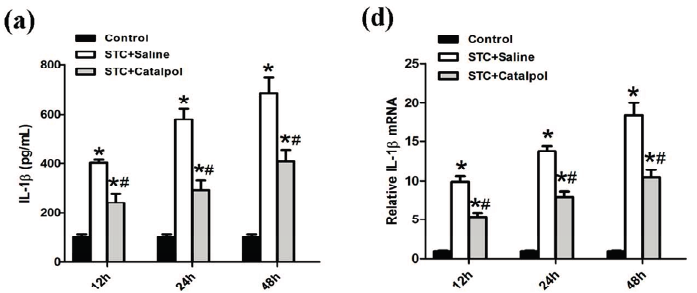
Figure 4. Serum proinflammatory cytokines, such as IL-1 β , IL-6 and TNF- α were measured using ELISA ( a , b , c ); IL-1 β , IL-6 and TNF- α mRNA levels were detected using quantitative RT-PCR ( d , e , f ) using GAPDH mRNA as the housekeeping control. Data are presented as means ± SD from three independent experiments. * p < 0.05, compared with the control group at the same time-point; # p < 0.05, compared with the STC + saline-treated group at the same